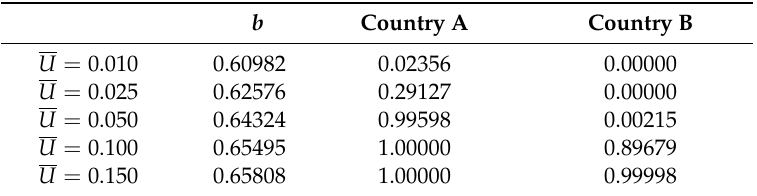
Table 2. Effects of U on the probability of reaching the optimal debt ceiling b